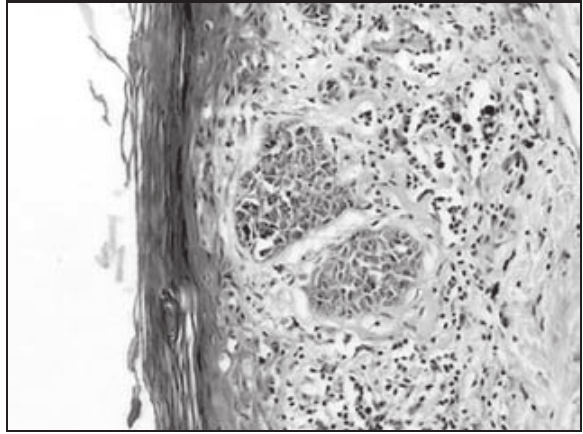
Figura 4 – Melanoma maligno nível II de Clark